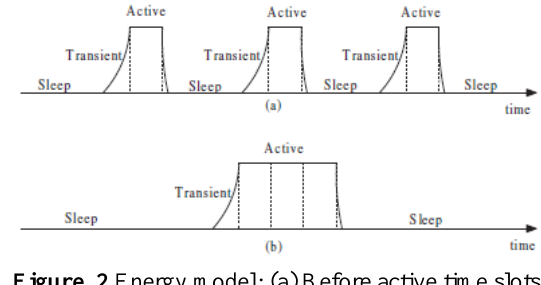
Figure. 2 Energy model: (a) Before active time slots merged, (b) After active time slots